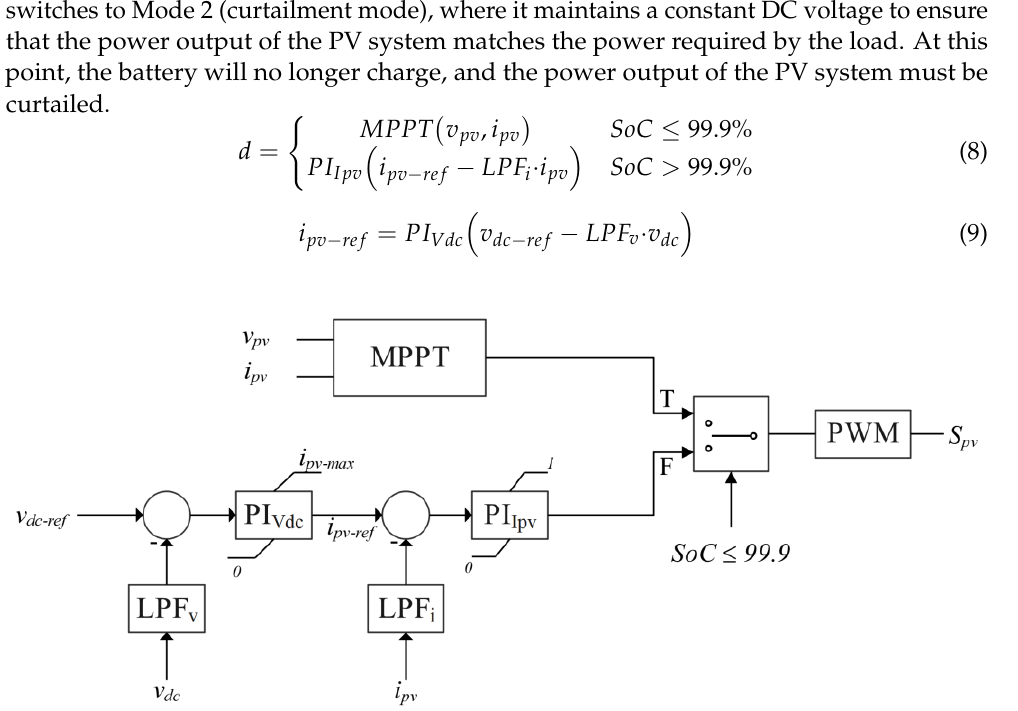
Figure 8. Block diagram of the control system for boost converter interfacing PV system and DC